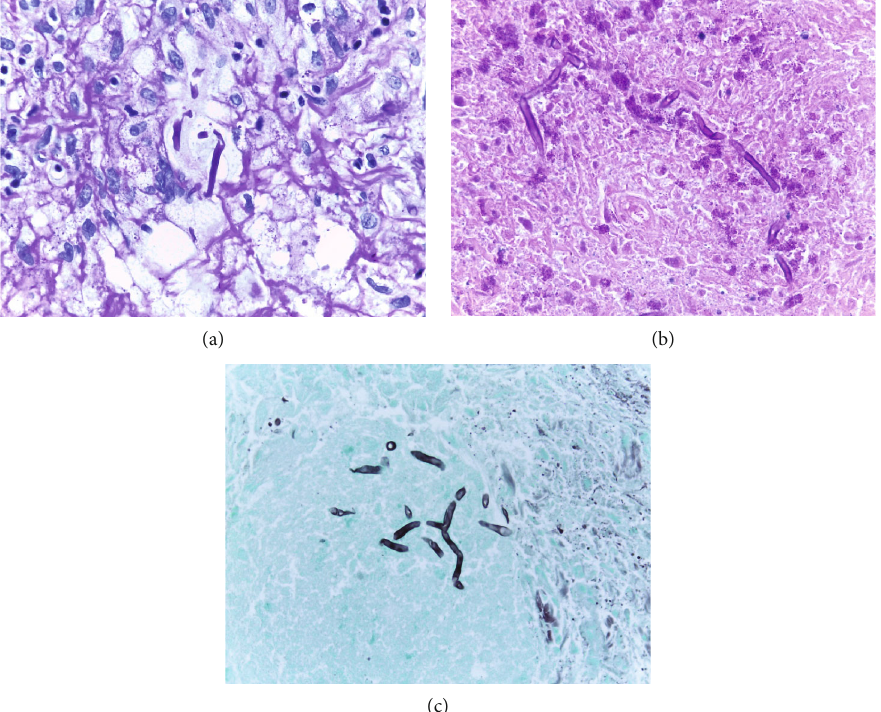
Figure 4: (a) Histopathologic section shows fungal hyphae in granulomatous in fl ammation background (H&E 400x). (b) Periodic acid-Schi ff (PAS) (600x). (c) Grocott methenamine silver (GMS) staining (600x). (b, c) Broad nonseptate and septate hyphae with the right angle branching on PAS and GMS.